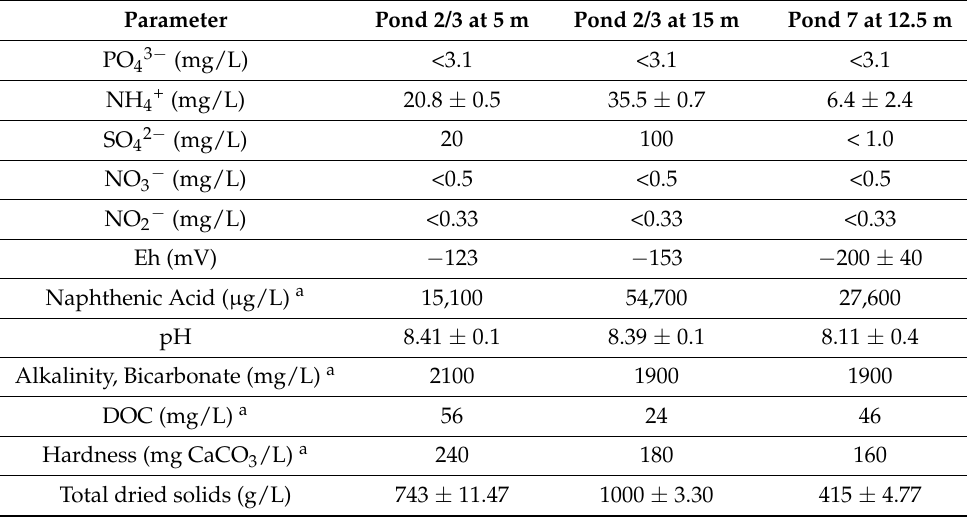
Table 1. Characterization of three MFT samples. a Per. Comm. E. Hollander, Suncor